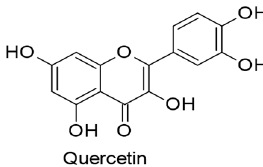
Figure 12. Chemical structure of quercetin with therapeutic effect against KSHV-positive primary effusion lymphoma (PEL) cells.